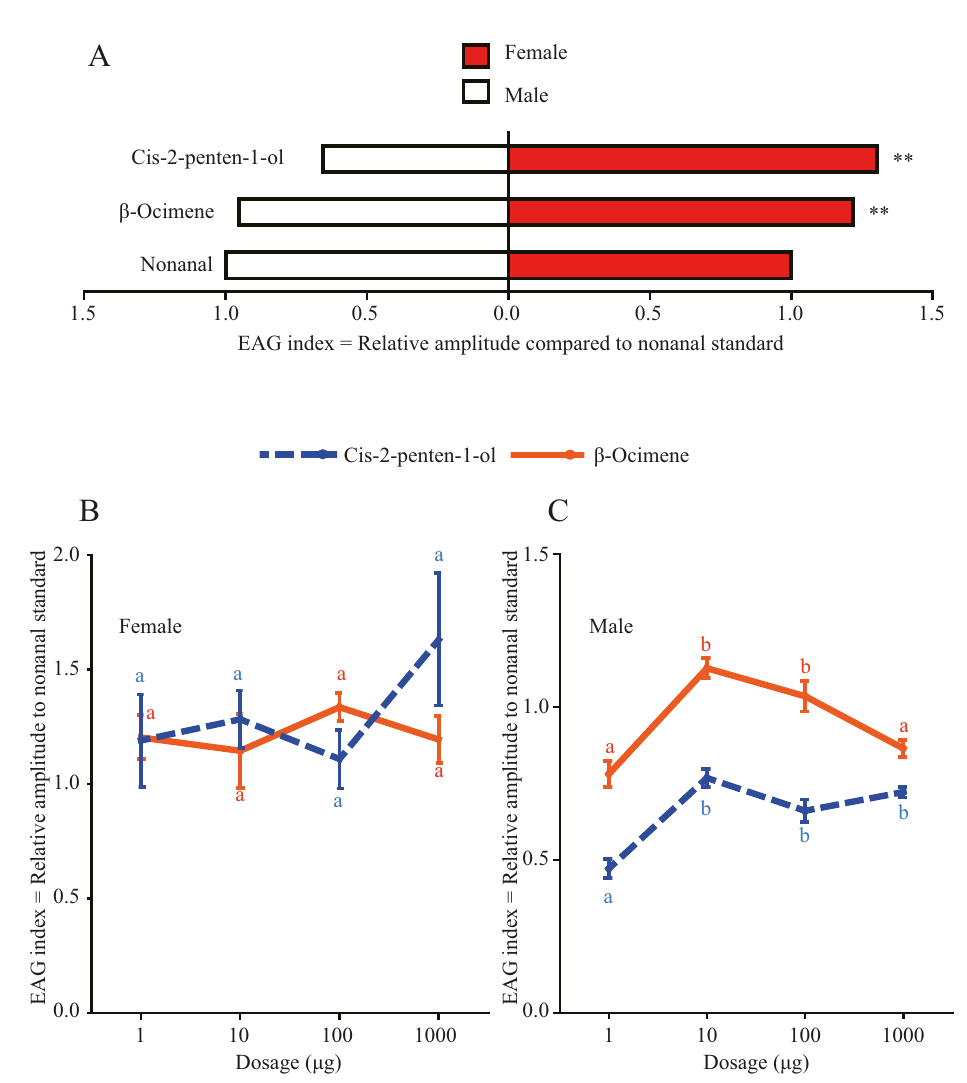
Figure 1. Comparison of electrical response intensities in antennae of male and female Hyphantria cunea moths towards the mulberry volatiles β -ocimene and cis -2-penten-1-ol: ( A ) averaged across dosages with asterisks indicating significant differences of electric responses level between sexes according to GLM at p < 0.05, n = 53; ( B ) of females per dosages, n = 7 and ( C ) of males per dosages, n = 6; with letters indicating significant differences between the two volatiles according to Tukey HSD after ANOVA at p < 0.05; Error bars = SEM, EAG = electroantennogram.